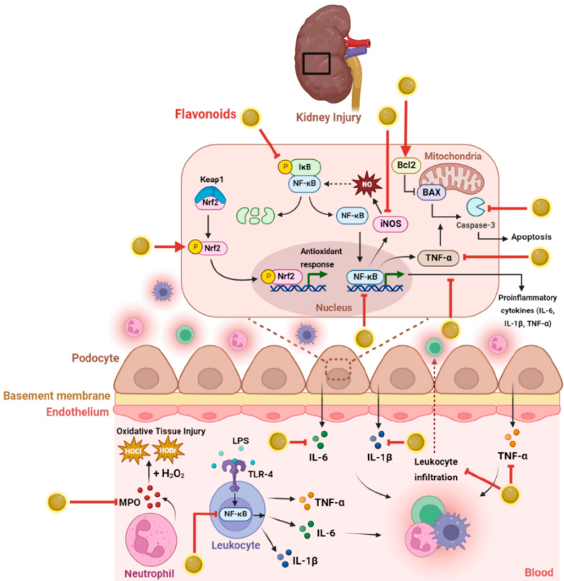
Figure 3. Mechanism of action of flavonoids in renal protection against oxidative stress, apoptosis, and inflammation. The first mechanism of flavonoids in response to